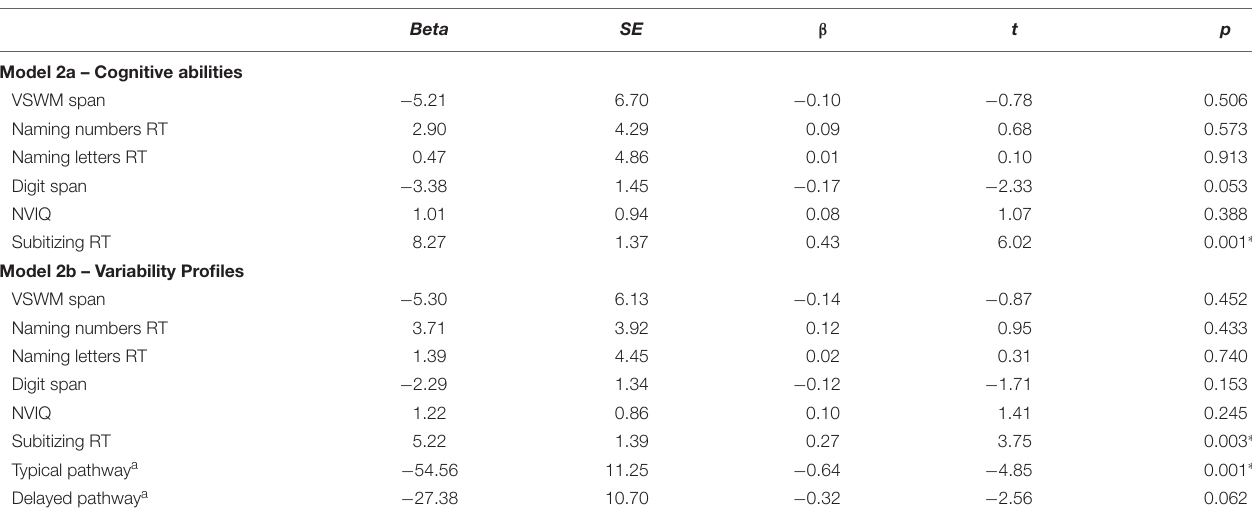
TABLE 6 | Model 2: Linear regression predicting DDA PRT